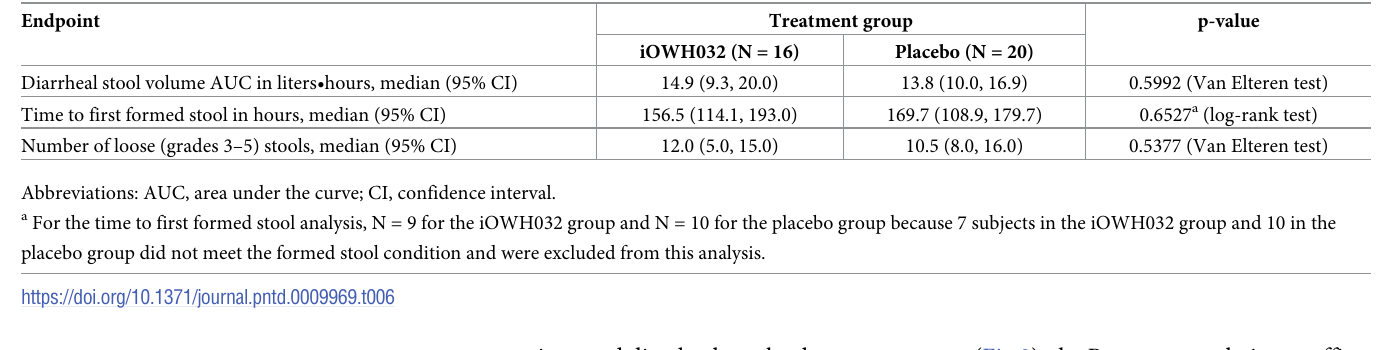
Table 6. Secondary efficacy endpoints for the modified intent-to-treat population.